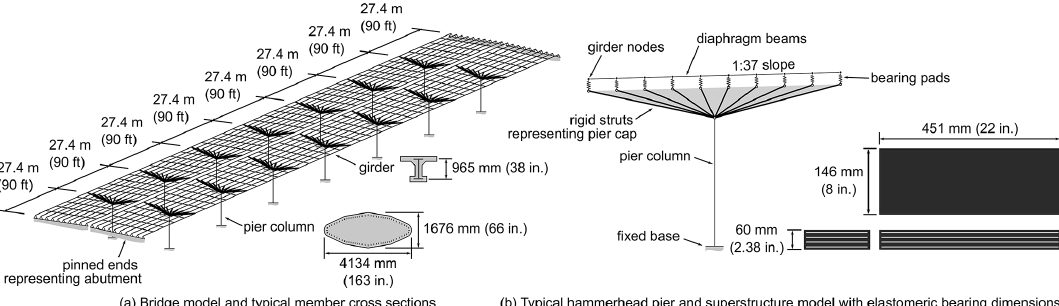
Figure 4. Approximate geometry of M6 bridge as modeled in OpenSees including pier column, girder and bearing dimensions shown (not to